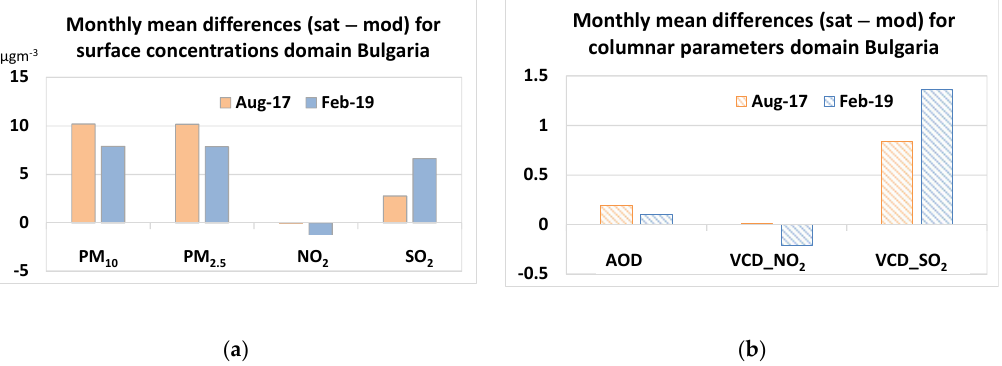
Figure 7. Monthly mean differences (BgCWFS_sat − BgCWFS_mod) averaged for domain Bulgaria: ( a ) for surface parameters in ( µ gm − 3 ); ( b ) for columnar parameters VCD_NO 2 and VCD_SO 2 in µ gcm − 2 .